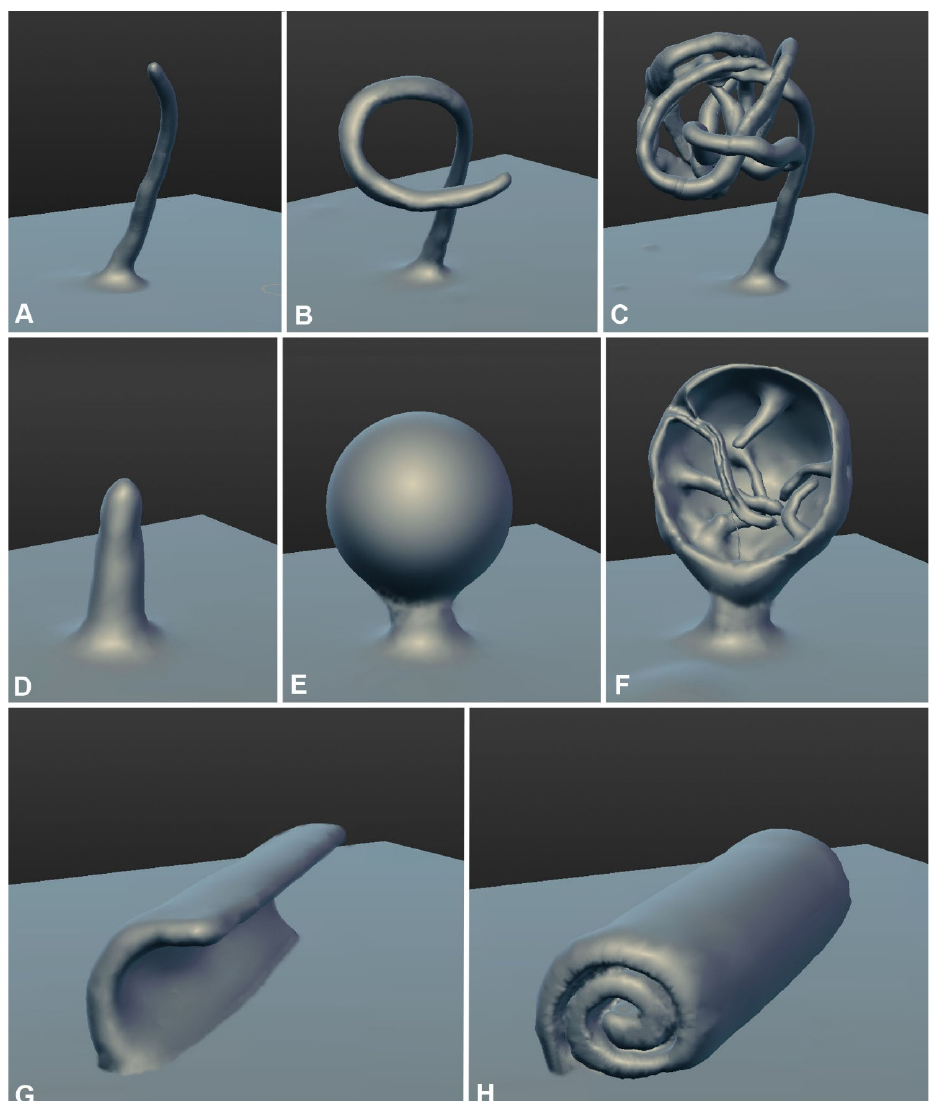
Figure 10. Three assumed mechanisms for the formation of glomeruli and pendants (same as lo- masomes) in basidial xylotrophs. ( A – C )—invagination of the PM in the form of a long